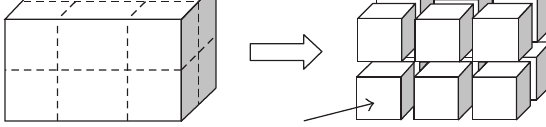
Domain Figure 3: A domain decomposition